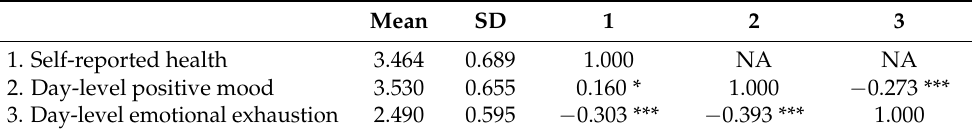
Table 1. Means, standard deviations, and correlations between the study variables.